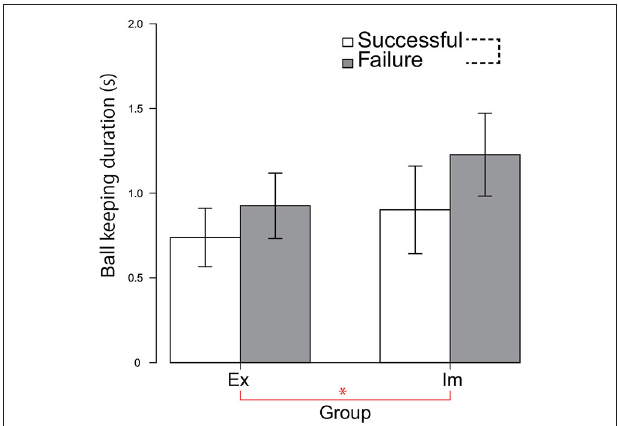
FIGURE 6 | Ball-keeping duration for each of the successful and failed passes. The value indicates the mean of the median calculated for each of the six game data. The data for one game in both the Ex and Im groups was excluded owing to missing data. * indicates a significant main effect of the group. The black dotted line connecting two elements of the legend indicates the trend ( p = 0.09) for the significant main effect of the pass